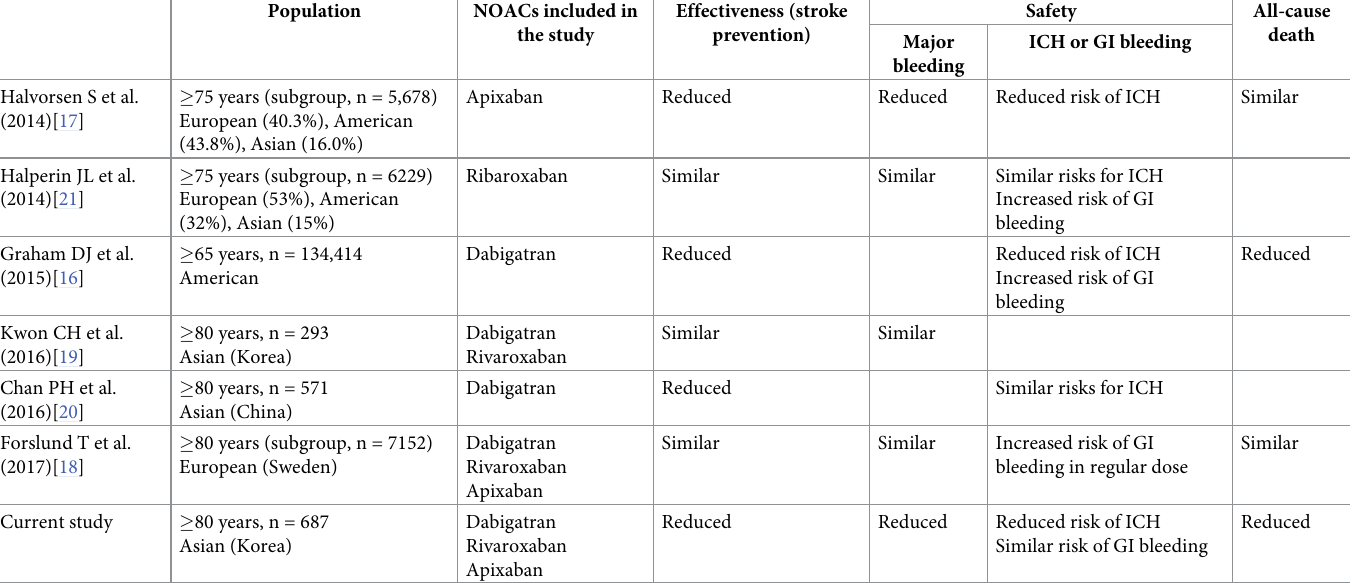
Table 2. Comparisons of previous studies for the effectiveness and safety of NOACs in elderly patients compared with